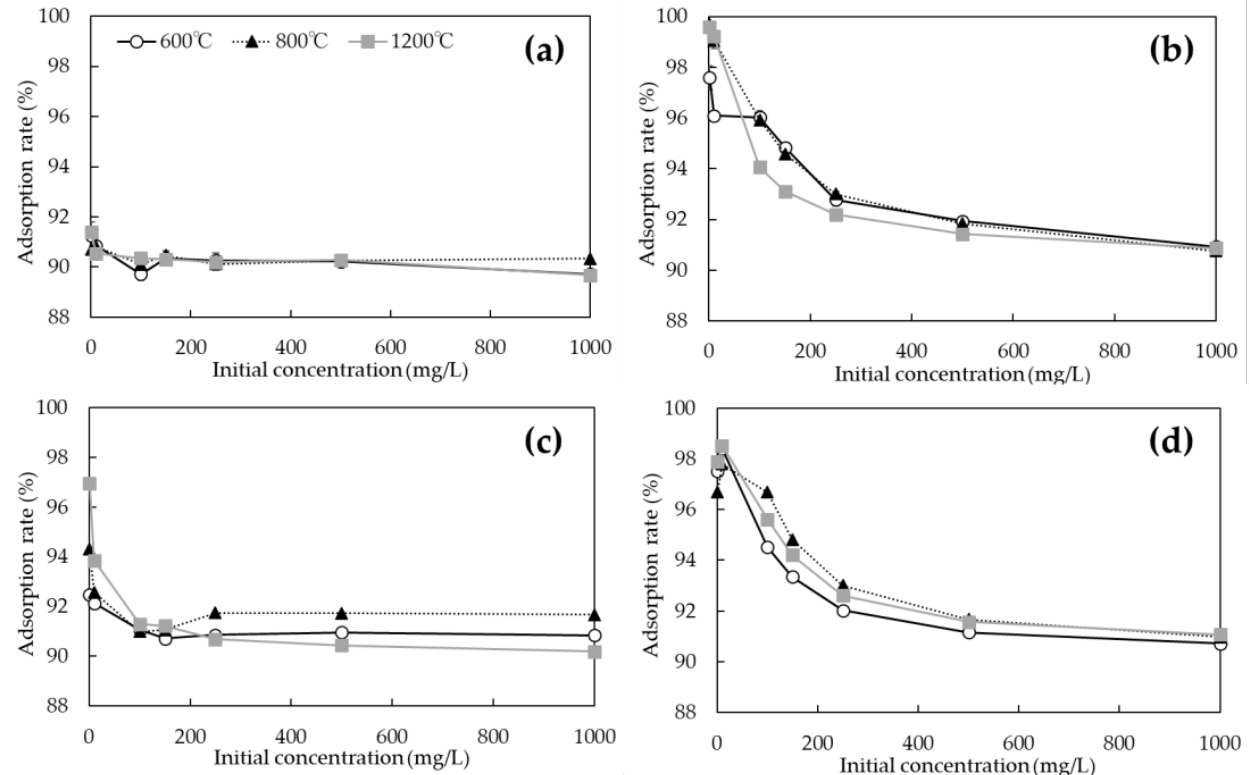
Figure 7. Adsorption rates of As(V) and Cd on biochars with and without chemical modification at each initial concentration. ( a ) As(V) adsorption of unmodified biochar; ( b ) Cd adsorption of unmodified biochar; ( c ) As(V) adsorption of FeCl 3 -modified biochar; ( d ) Cd adsorption of NaOH-modified biochar.